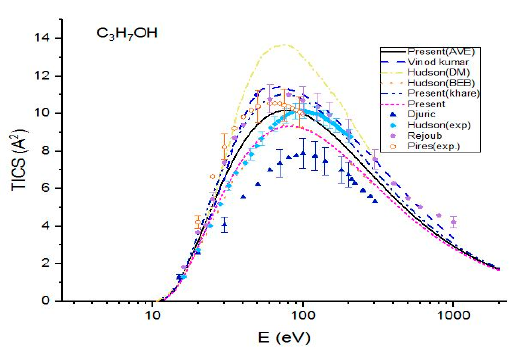
Figure 3. Total ionization cross sections (TICS) for C 3 H 7 OH in A 2 , the solid line represents the present (Ave.) results, the dash line represents the theoretical results measured by Vinod kumar et al. [8], the dash dot represents the theoretical results measured by Hudson et al. [9] using DM formulism, the dot line represents the BEB calculations of Hudson et al. [9], the dash dot dot line represents the present (Khare BEB), the short dash represents the present results. Filled triangles, filled squares, filled pentagons and open hexagonals are the experimental results of Djuric et al. [11], Hudson et al. [9] Rejoub et al. [12] and Pires et al. [14], respectively .